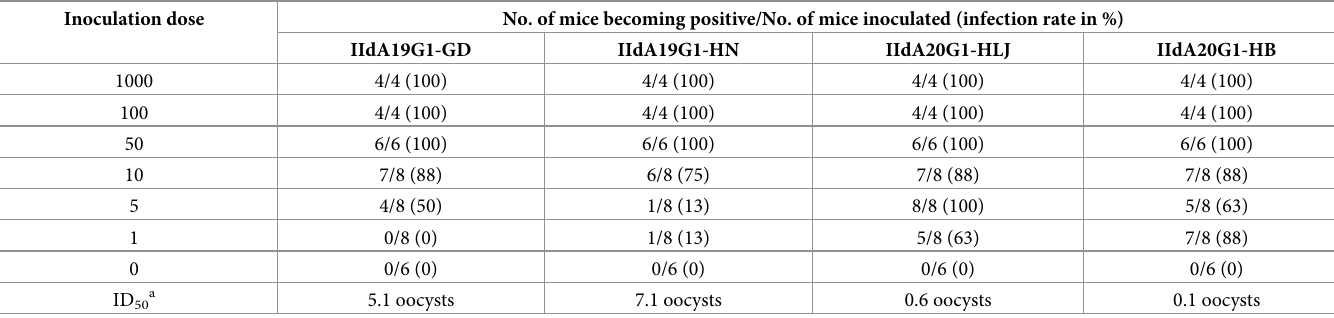
Table 1. Infectivity of four IId isolates of Cryptosporidium parvum in interferon- γ -knockout mice. Inoculation dose No. of mice becoming positive/No. of mice inoculated (infection rate in